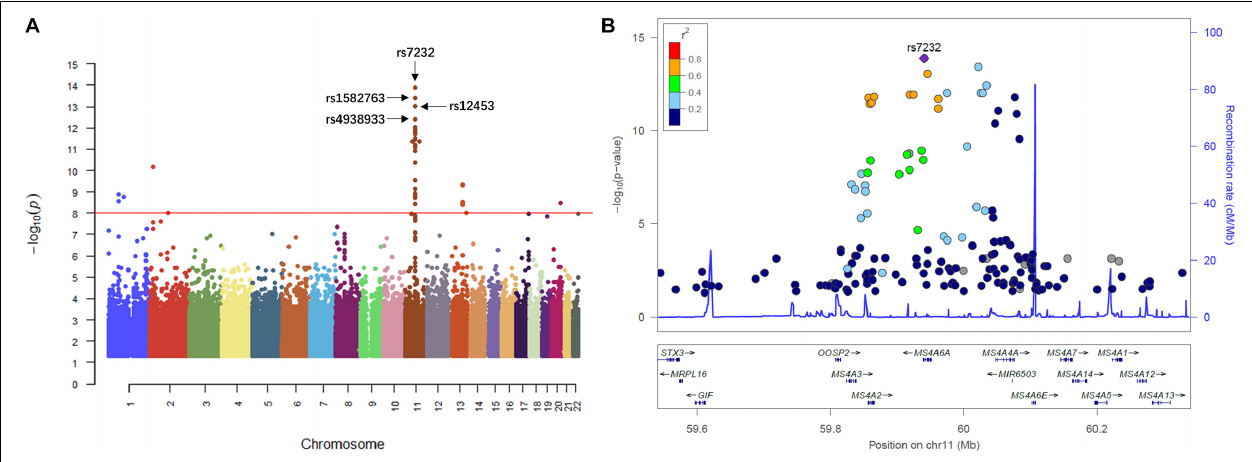
FIGURE 2 | Manhattan plot and regional plot of the results from QTL analysis for CSF sTREM2 levels. (A) Manhattan plot of –log 10 ( p -value) from the results of QTL analysis. (B) Regional plot for the most significant SNP rs7232 identified by the QTL analysis. The r 2 measures the linkage disequilibrium of each SNP with the most